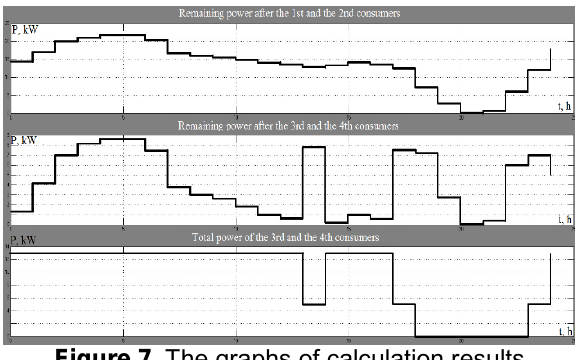
Figure 7. The graphs of calculation results